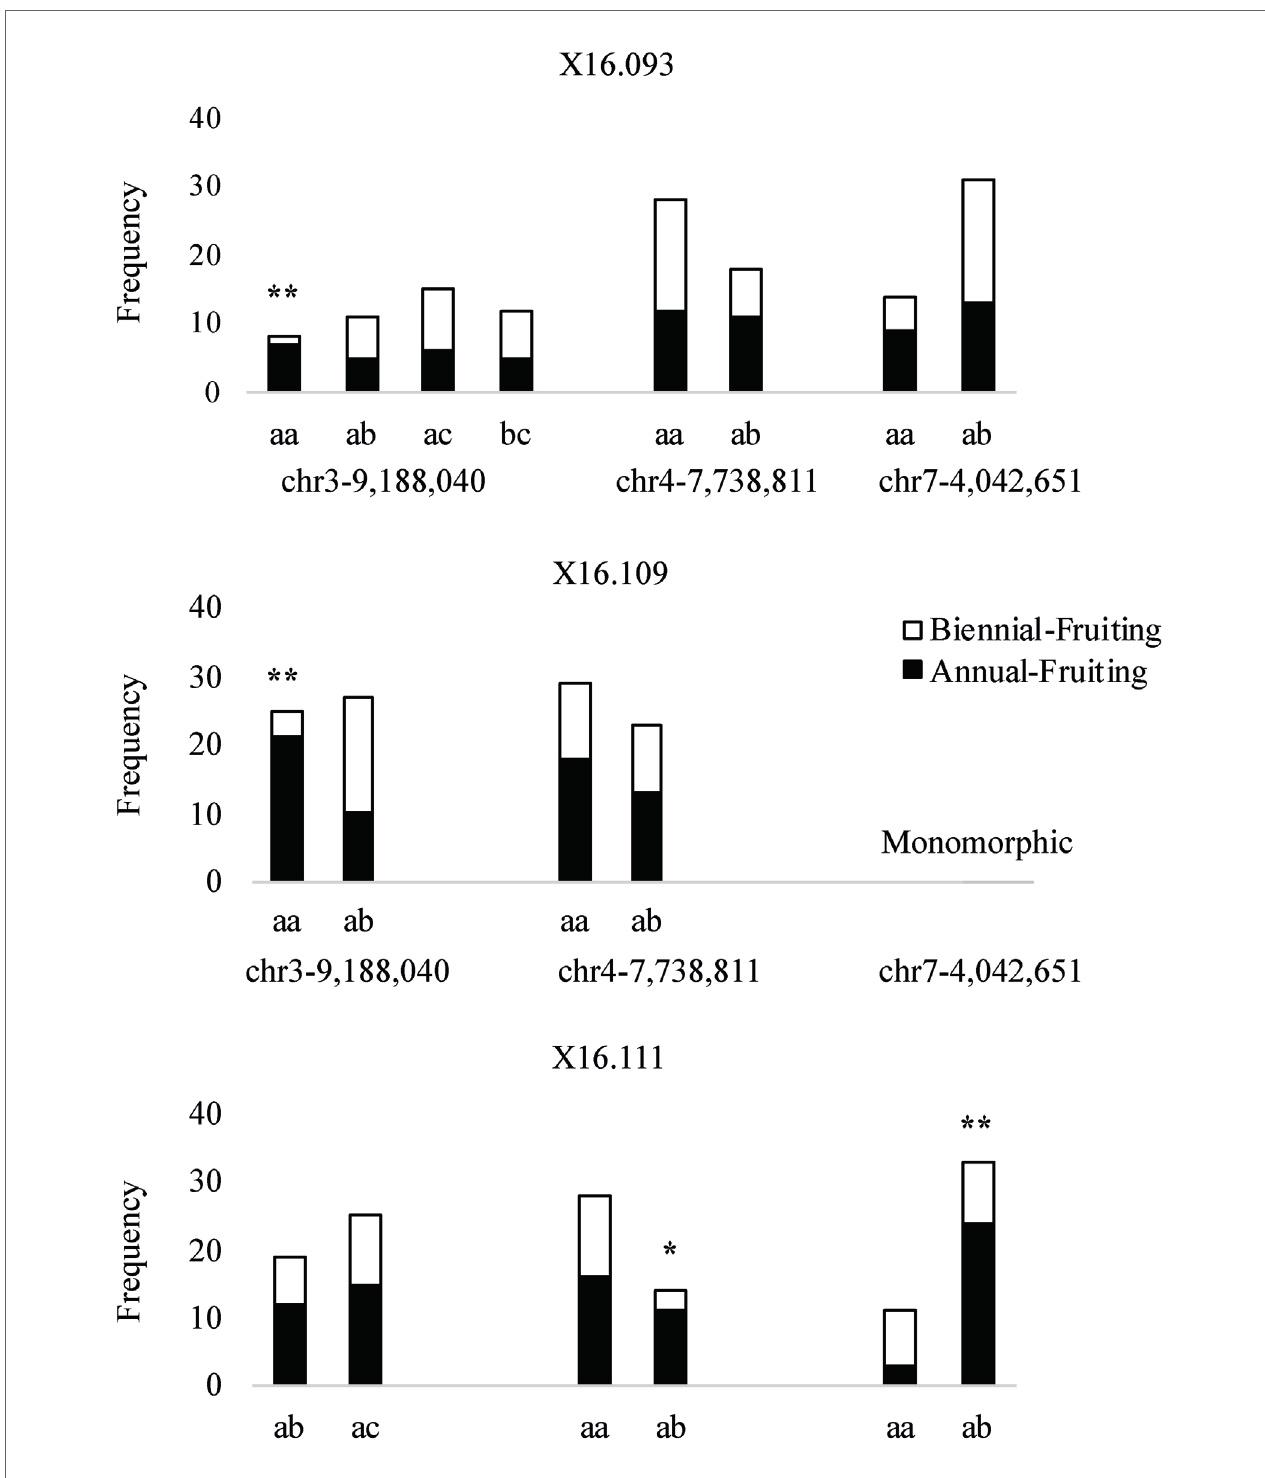
FIGURE 5 | Histograms showing allelic frequencies of SNP-based markers underlying quantitative trait loci in three independent red raspberry populations segregating for the Annual-Fruiting trait. The marker names indicate their chromosome and physical positions (in bp) on the Rubus occidentalis genome (Vanburen et al., 2018). The * and ** represent chi-square test significance of 95% and 99% (d.f. = 1), respectively. The marker chr7-4,042,651 was monomorphic in the x16.109